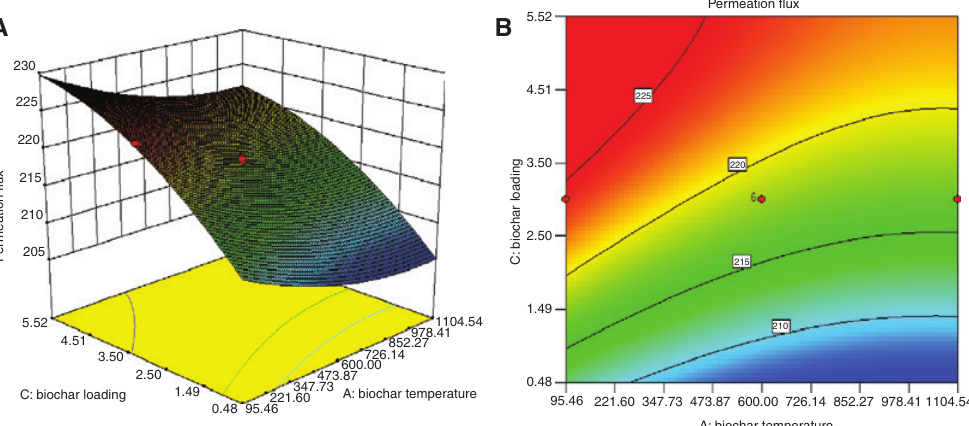
Figure 7: 3D surface plot (A) and contour plot (B) exhibiting the influences of the BB temperature and the BB loading amount on the permeation flux.